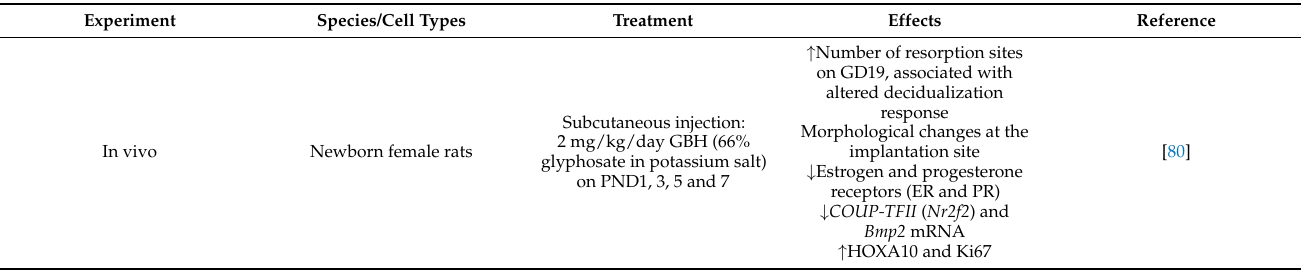
Table 1. In-vivo and in-vitro administration of glyphosate and glyphosate-based herbicides (GBHs): effects on reproduction in